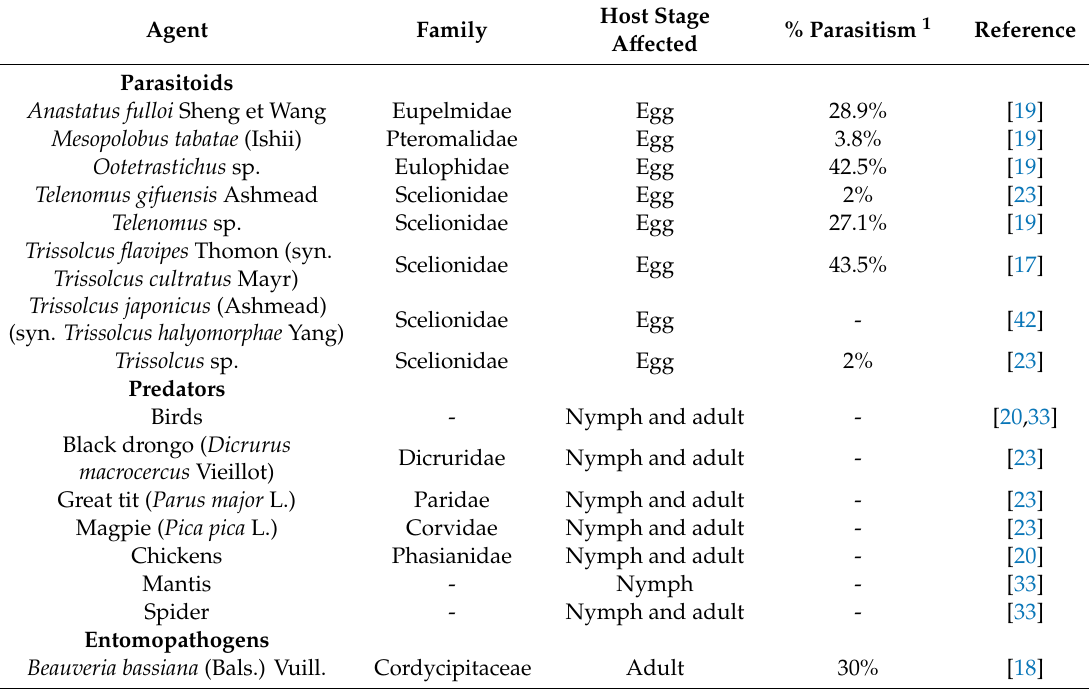
Table 3. List of potential natural enemies against Erthesina fullo identified in